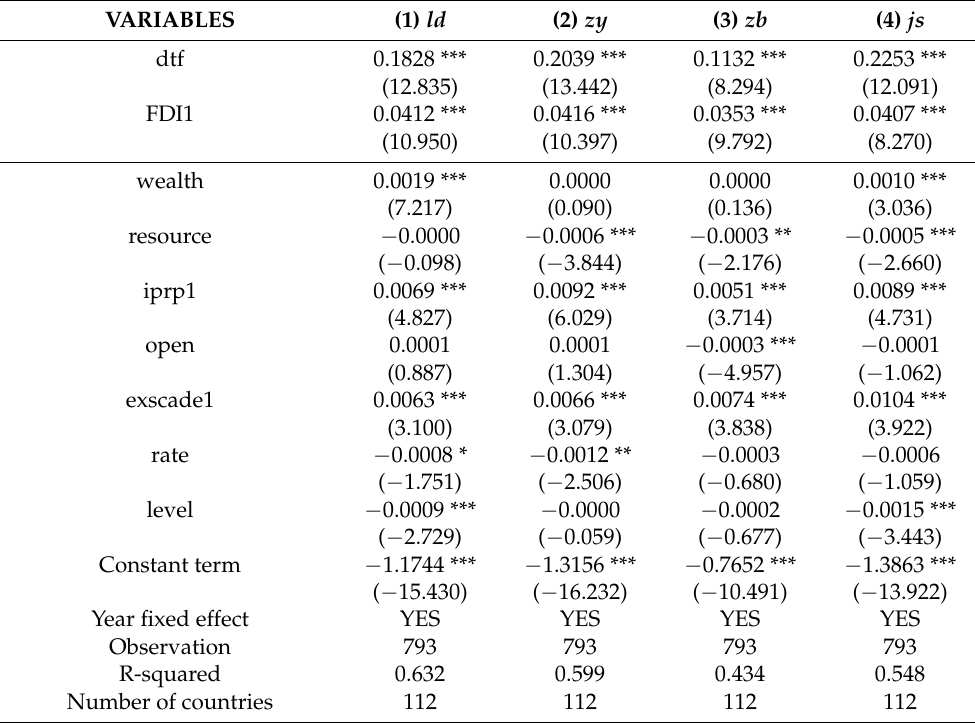
Table 4. Heterogeneity